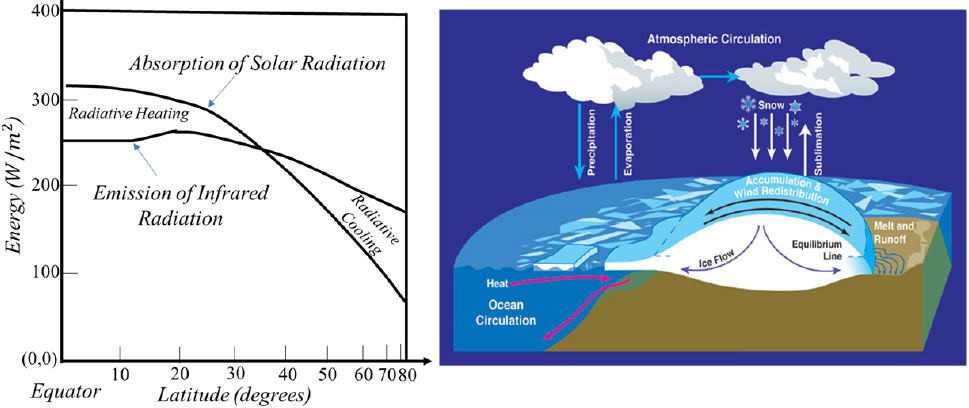
Figure 7. Absorbing solar radiation and emitting long-wave radiation averaged over latitude and atmospheric circulation